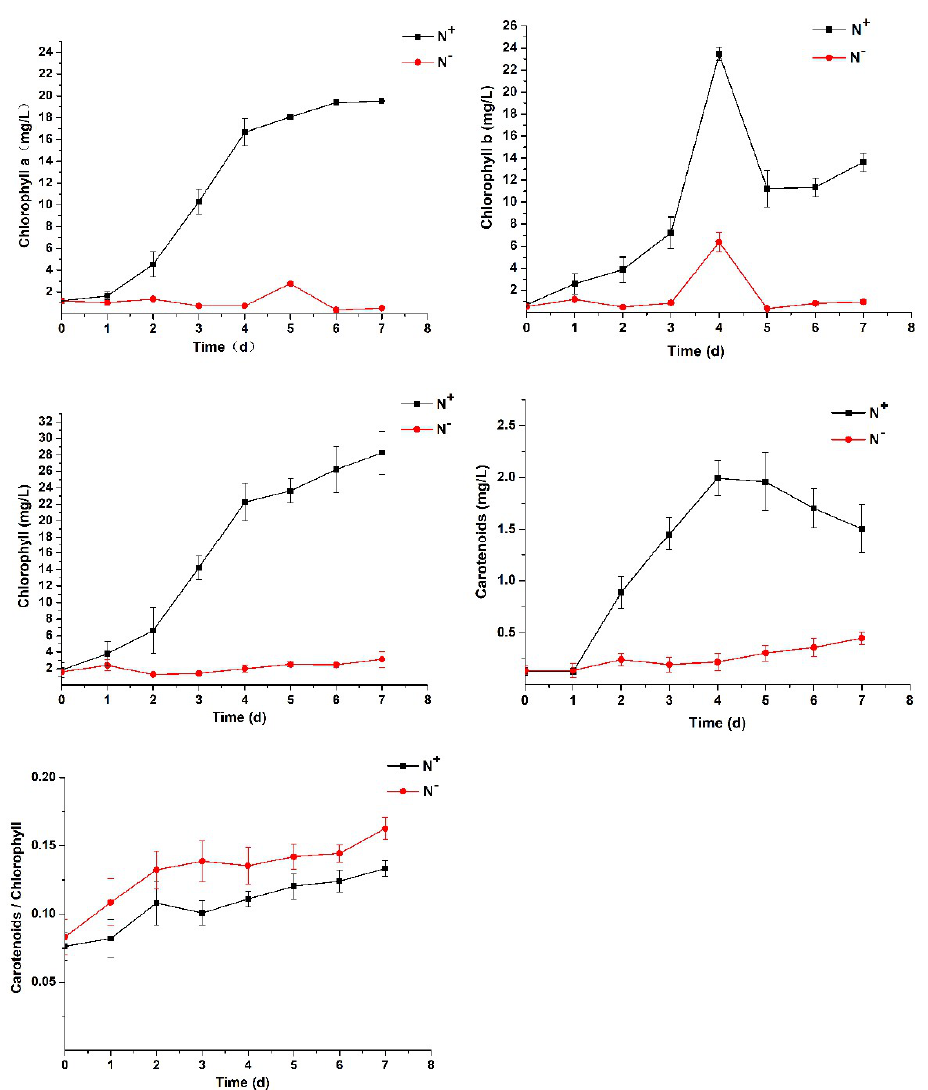
Figure 3. Comparison of chlorophyll and carotenoids contents of Parachlorella kessleri TY02 under N + and N − culture media. Data are shown as mean ± SE. n = 3.